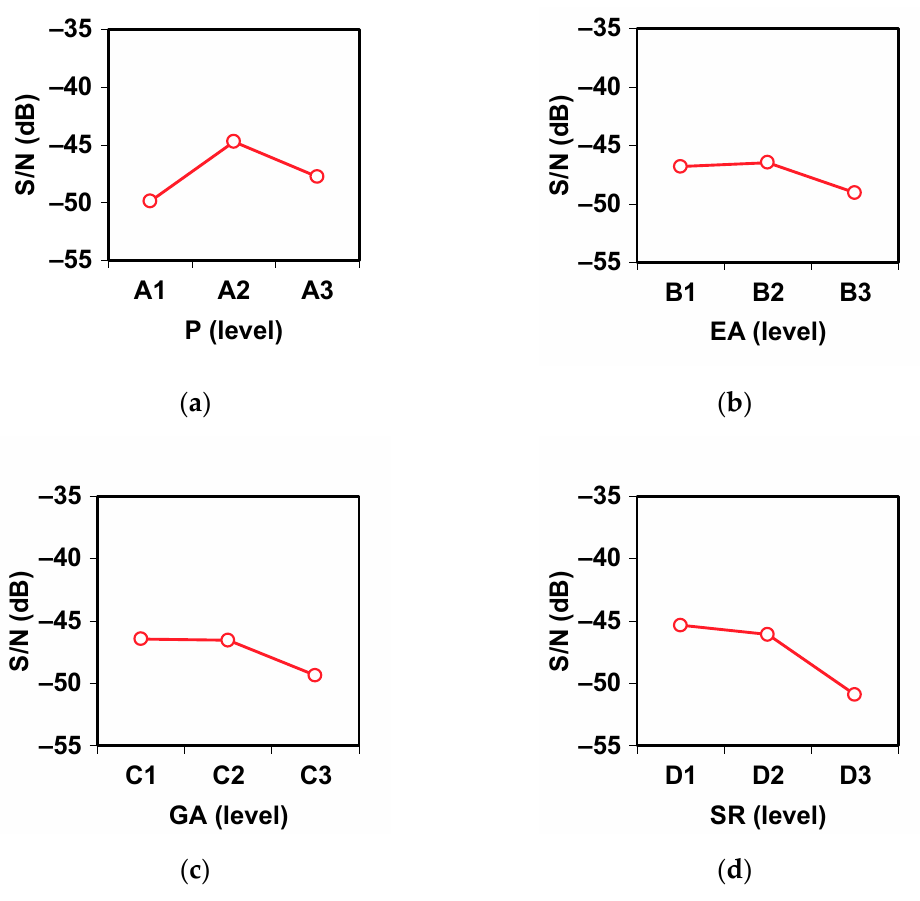
Figure 6. Individual influence of factors on the response (CO) S/N obtained for the three leves of ( a )